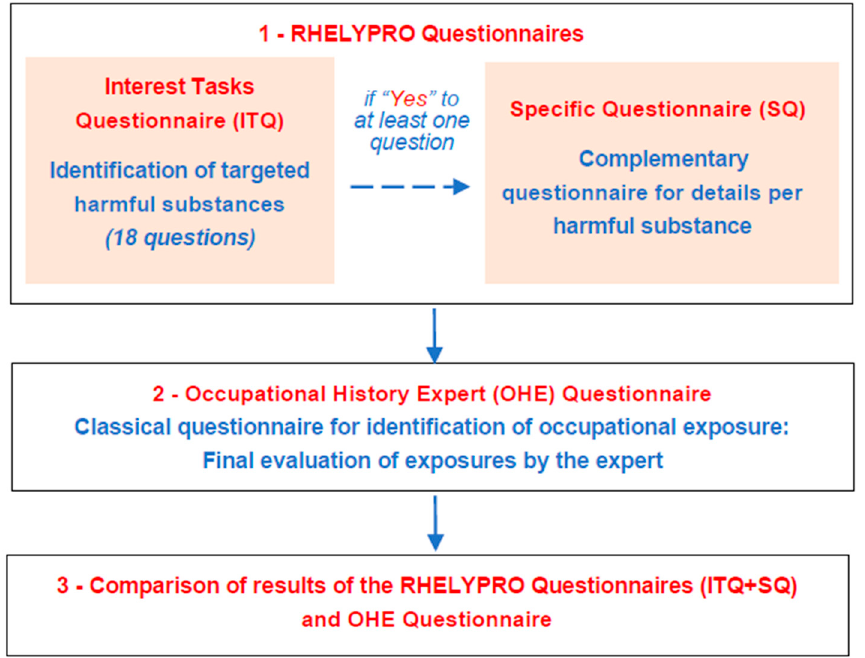
Figure 1. Process for the administration and exploitation of the occupational questionnaires (see in Supplementary Materials: Questionnaire S1 for the Repérage des HEmopathies LYmphoïdes d’origine PROfessionnelle (RHELYPRO) questionnaires and Questionnaire S2 for the Occupational History Expert Questionnaire).